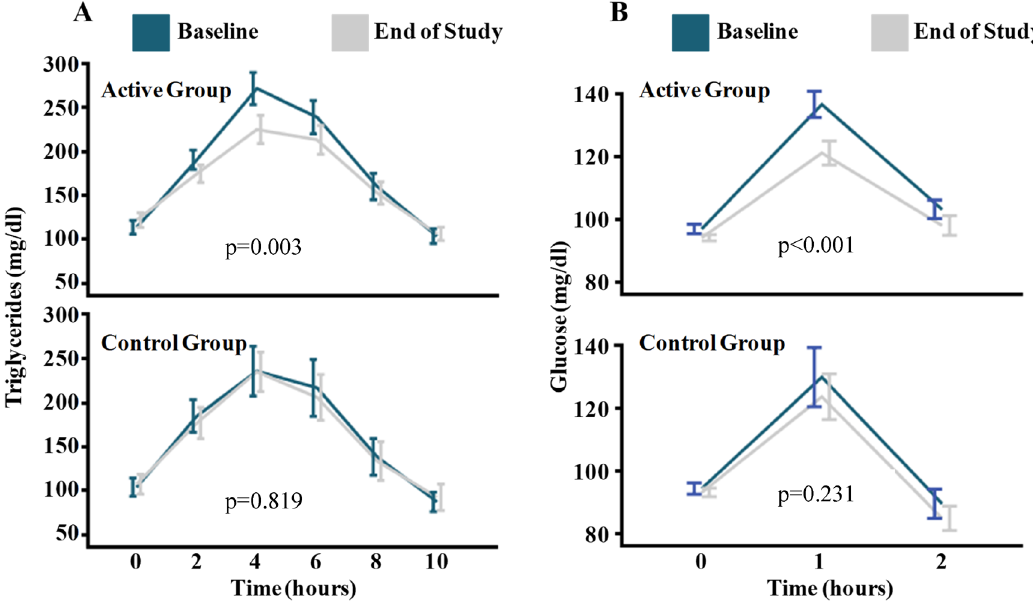
Figure 3. Comparison of the effects of eccentric endurance exercise with those of the control group on mean changes in postprandial triglyceride ( A ) glucose values ( B triglyceride tolerance (1923 ± 1295 vs. 1670 ± 1085 mg dl −1 h −1 ; p = 0.003), whereas triglyceride tolerance was not changed in the control group (1740 ± 976 vs. 1700 ± 955 mg dl −1 h −1 ; p = 0.819).